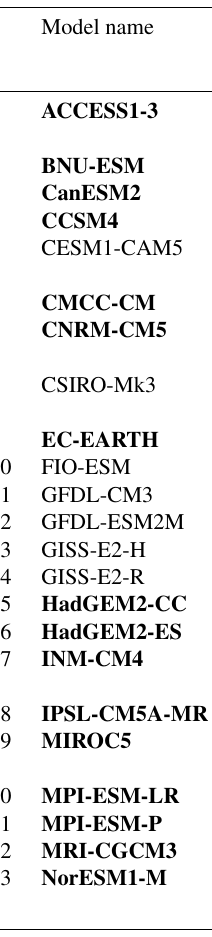
Table 1. Description of the 23 CMIP5 coupled models analysed in this study. Names in bold indicate the model retained for the evaluation of ITV (Sect.